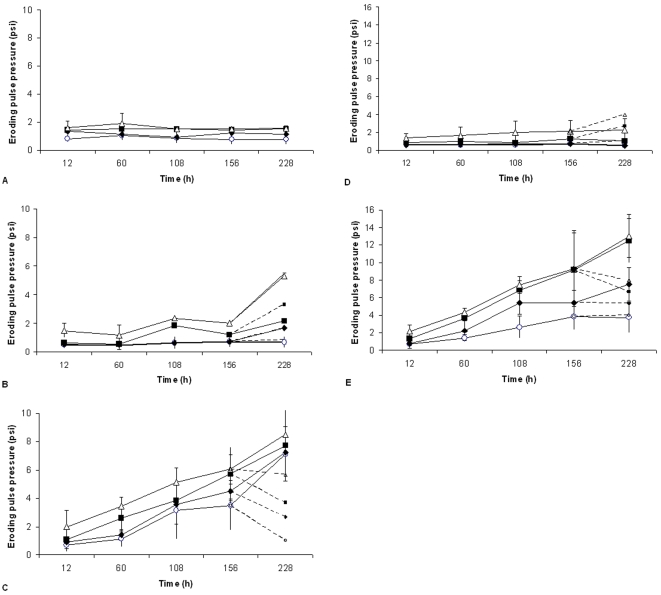
Erosion profiles from stromatolite material and controls measured during the summer.The mean pressure required to cause a specific level of erosion (particle resuspension causing a reduction in transmission, o = 10%, ♦ = 20%, ▪ = 50% and Δ = 75%, n = 7) against period of incubation for each of the experimental sites. A. Control of beach sand. B. Experimental replicates held in continuous darkness from site 1. For the penultimate incubation period, 3 replicates were transferred to the alternate condition (ambient light) as indicated by the dotted lines. C. Experimental replicates from site 1 kept under ambient light and temperature conditions. For the penultimate incubation period, 3 replicates were transferred to the alternate conditions (darkness) as indicated by the dotted lines. D. Experimental replicates from site 10 held in continuous darkness. For the penultimate incubation period, 3 replicates were transferred to the alternate condition (ambient light) as indicated by the dotted lines. E. Experimental replicates from site 10 kept under ambient light and temperature conditions. For the penultimate incubation period, 3 replicates were transferred to the alternate conditions (darkness) as indicated by the dotted lines. (n = 7 for all treatments except where stated).